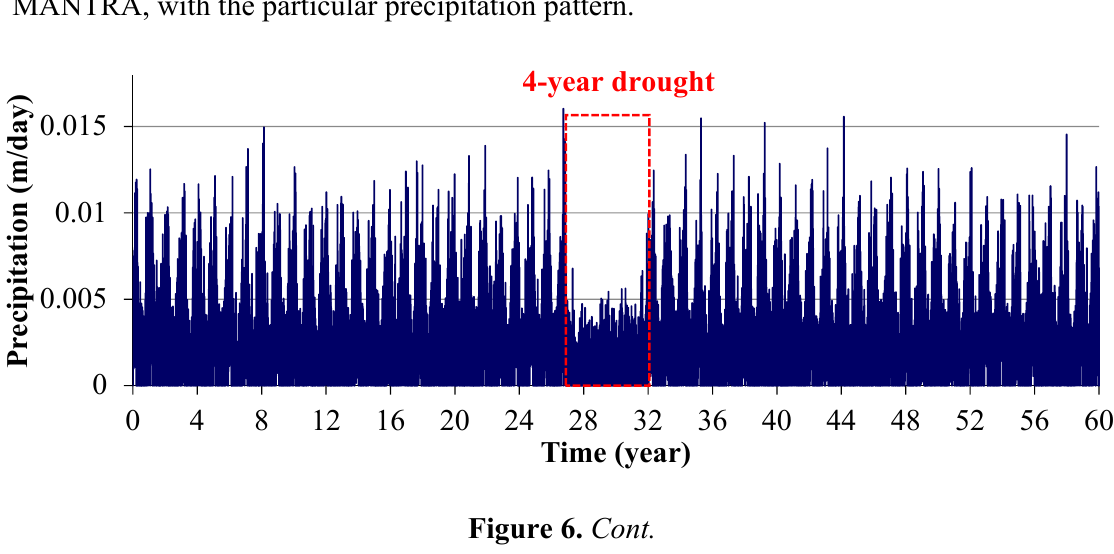
Figure 5. ( a , Top ) Depiction of initial conditions following storm surge, with almost complete elimination of hardwood hammock living biomass through knockdown of trees. Faded blue colors indicate destruction of initial trees. ( b , Second from top ) Simulated salinity profile during the storm surge. ( c , Third from top ) Simulated distribution of mangrove (red) vegetation 16.4 years (6000 days) after the storm surge. ( d , Bottom ) Sequence of salinity profiles starting before the surge until two months after, as predicted by MANTRA, with the particular precipitation